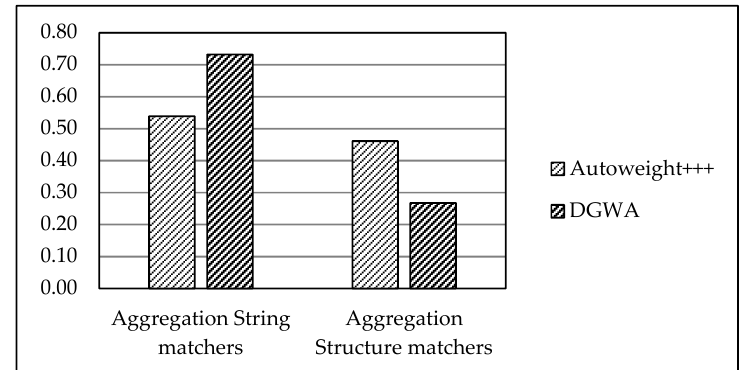
Figure 15. The average values of weighted factors assigned to the aggregation results of string and structure matchers by using aggregation methods Autoweight+++ and DGWA while matching the entire Benchmark biblio ontology track .